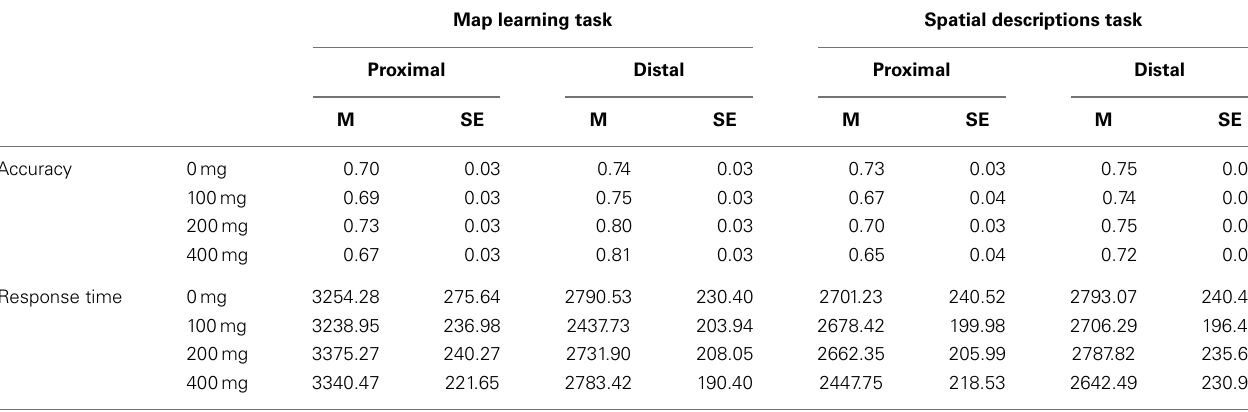
Table 4 | Map learning task and spatial description task mean accuracy and response time (SE) in high habitual caffeine consumers ( n =